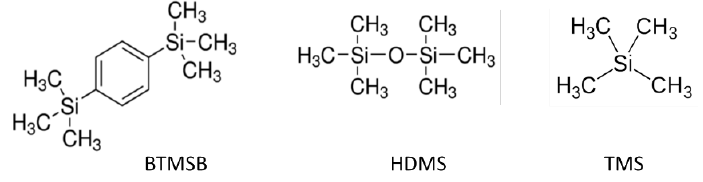
Figure 4. Chemical structure of BTMSB, HMDS, and TMS.